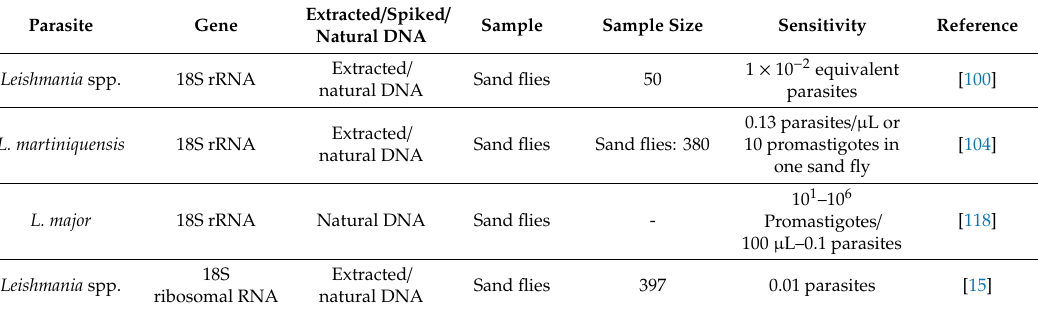
Table 9. Publications found in the US National Library of Medicine National Institutes of Health (NCBI-PubMed) reporting the standardisation of the LAMP technique as a useful tool for diagnosing leishmaniasis in the